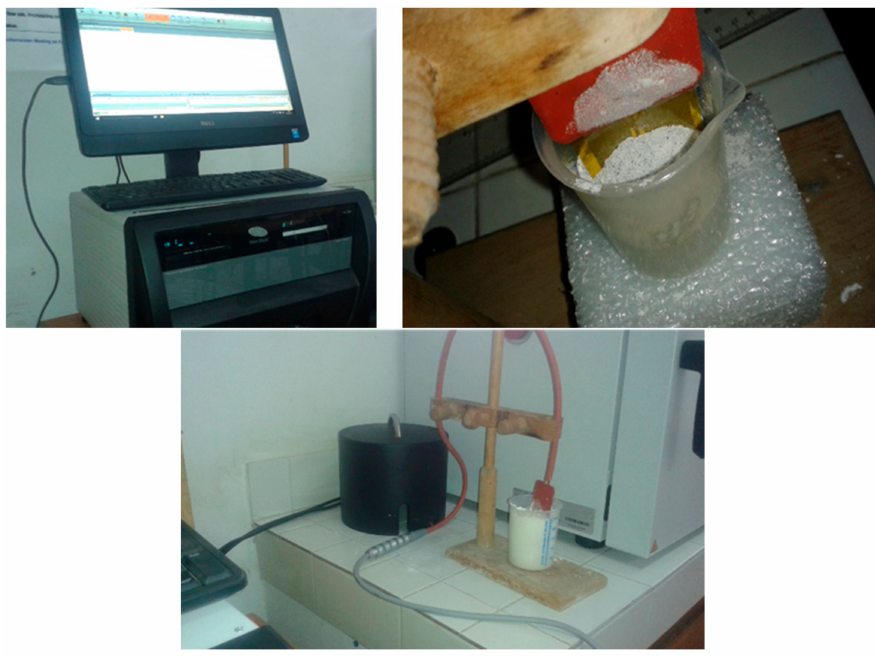
Figure 2. Hot disk thermal measurement